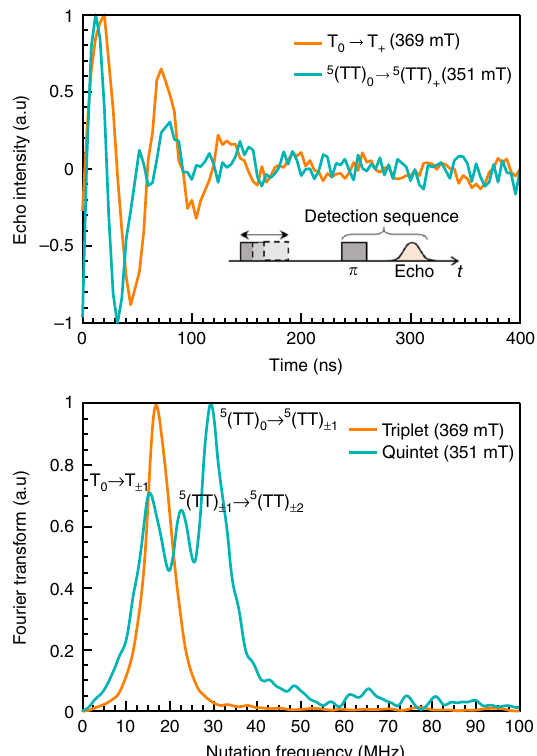
Fig. 5 Identifying quintet states at room temperature via nutation experiments. a Nutation experiment for the high- fi eld quintet and triplet transitions, with the pulse sequence shown in the inset. b Fourier Transform of data in a showing a ratio of 1.74 between the triplet and quintet nutation frequencies (16.85 and 29.3 MHz, respectively), in accord with the nominal value of √ 3 =